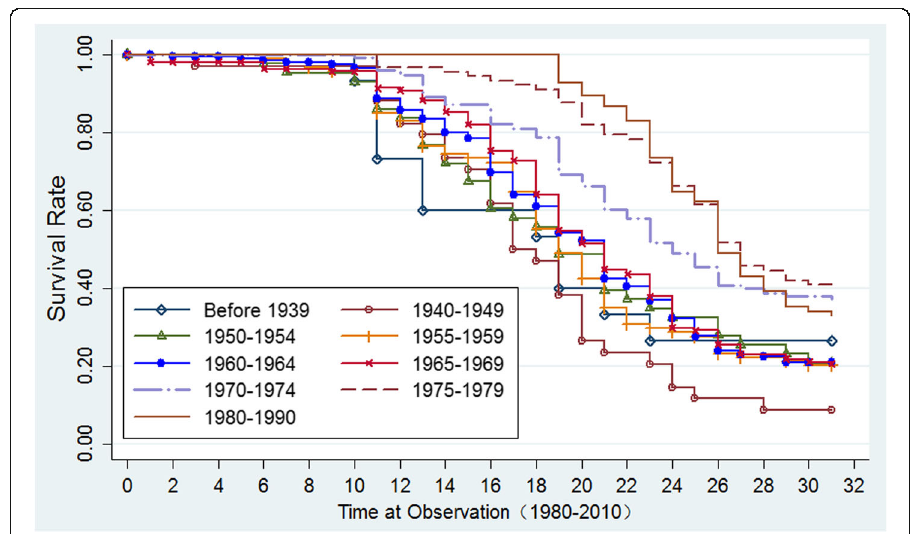
Fig. 4 Kaplan-Meier cumulative survival estimates for acquisition of the first housing property rights for each